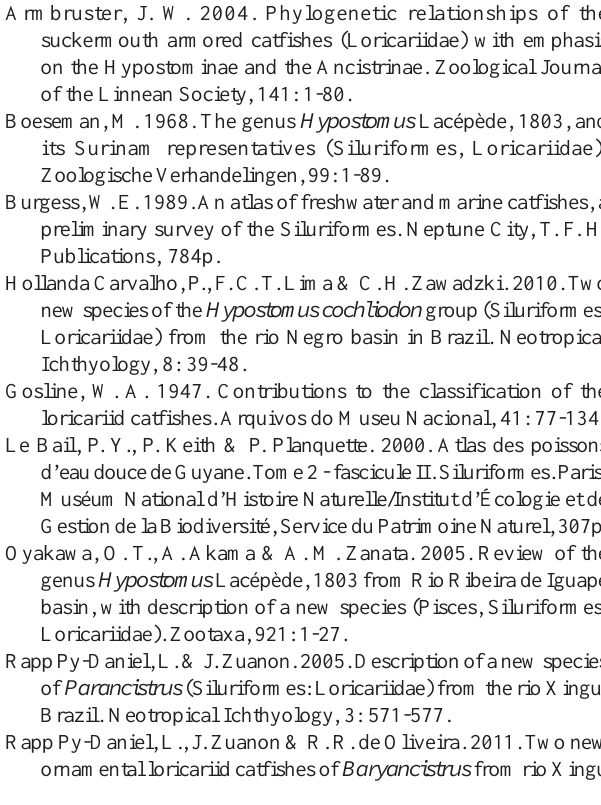
Table 2. Meristic data of Hypostomus kuarup . Dorsal series of